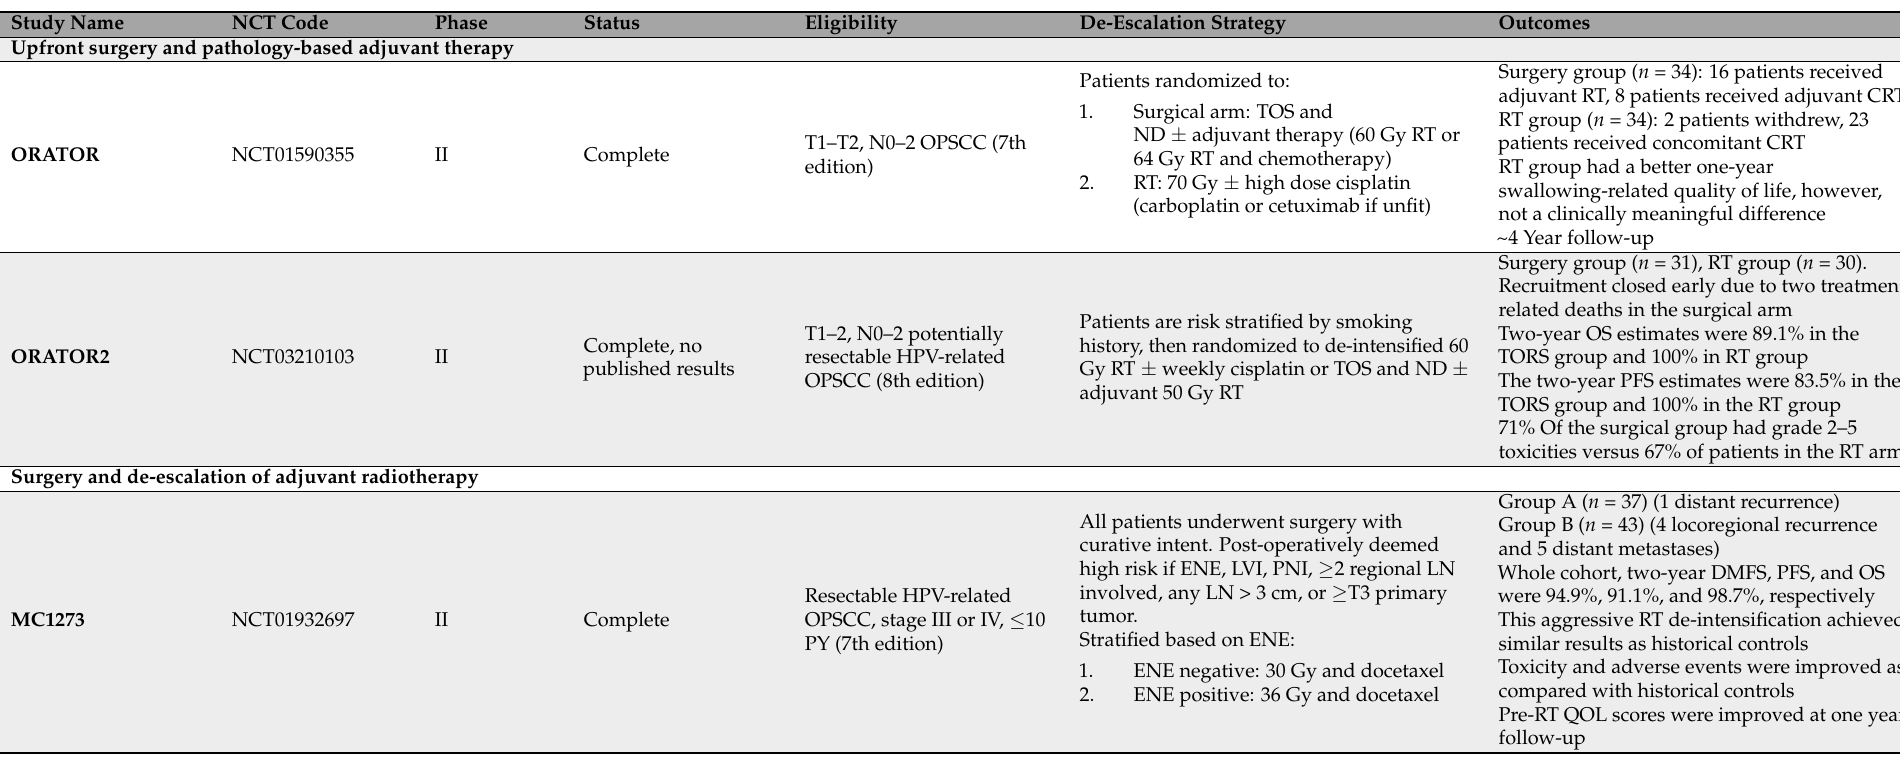
Table 1. Overview of both published and ongoing treatment de-escalation clinical trials for human papillomavirus-associated oropharyngeal squamous cell